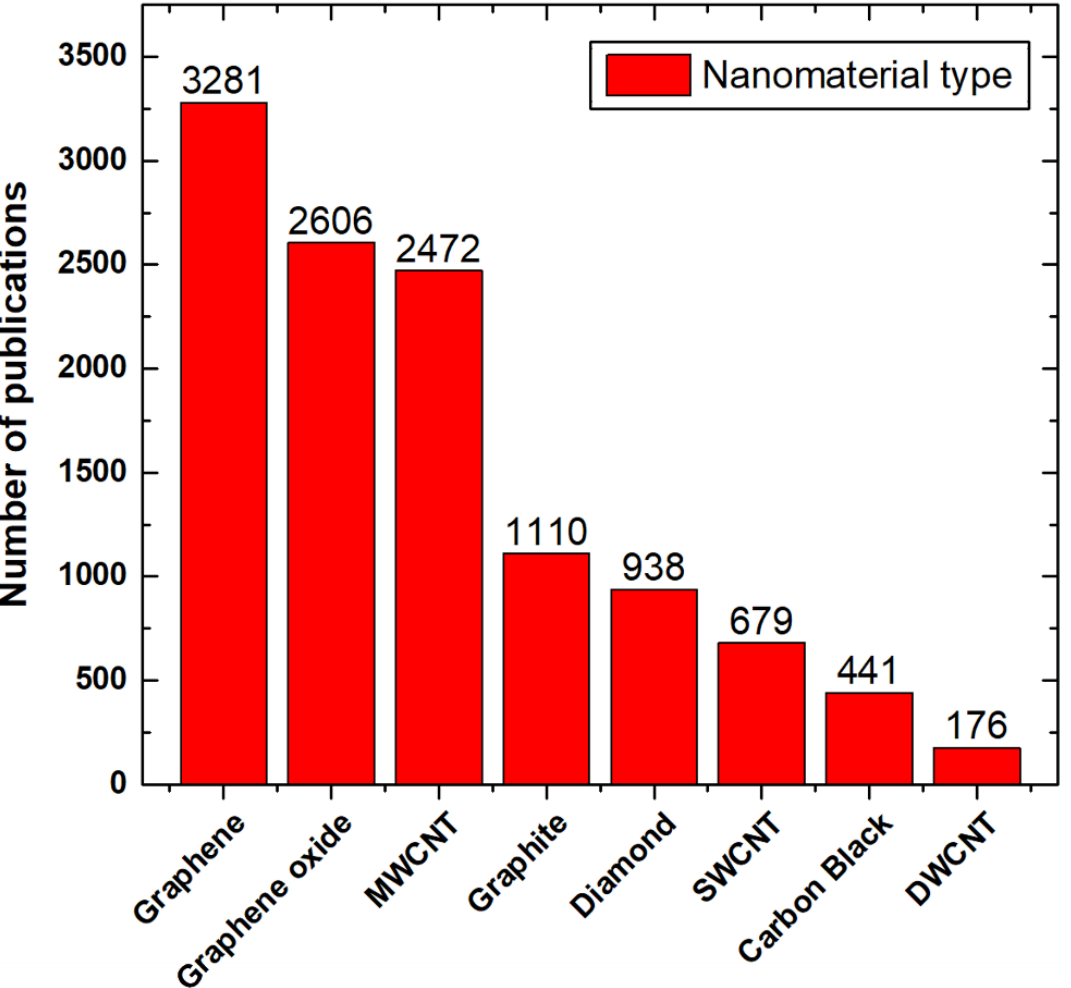
Figure 4. The number of publications available at the Scopus database for common carbon-based material used in nanofluids fabrication [35].